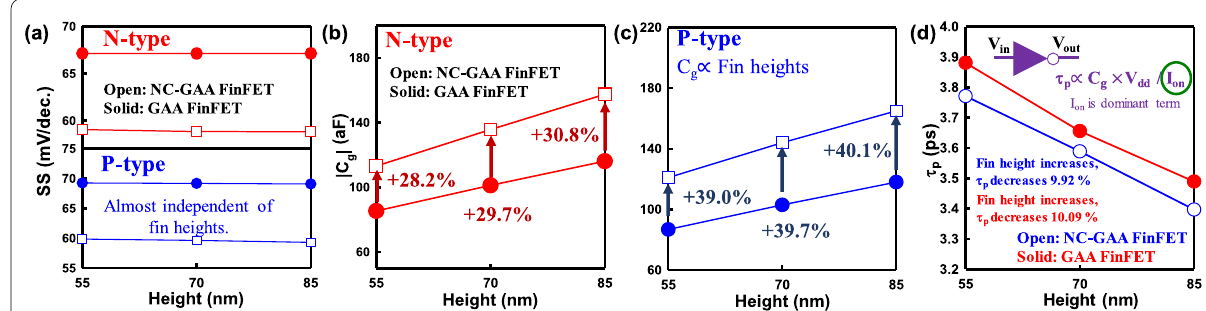
Fig. 7 a A comparison of SS for N‑/P‑type GAA and NC‑GAA FinFETs. The FE layer has the strong NC effect which causes SS lower than 60 mV/ decade. A comparison of C g for b N‑/, c P‑type GAA and NC‑GAA FinFETs. C g is increased as the fin height increases. d τ P of GAA and NC‑GAA FinFETs. τ